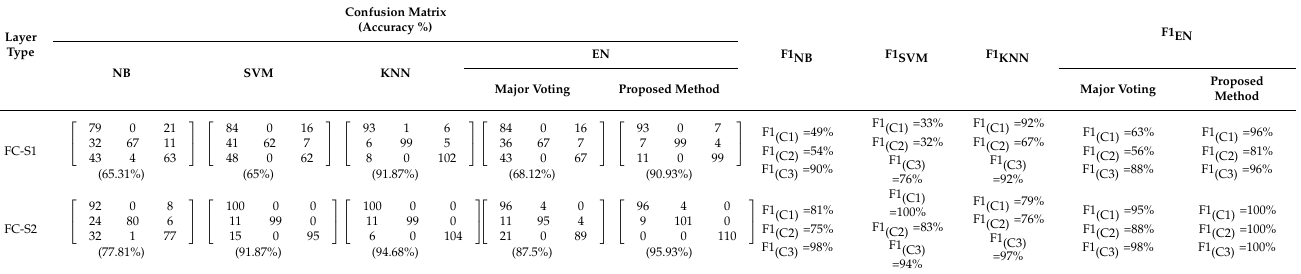
Table 9. Validation results of the FC layer.